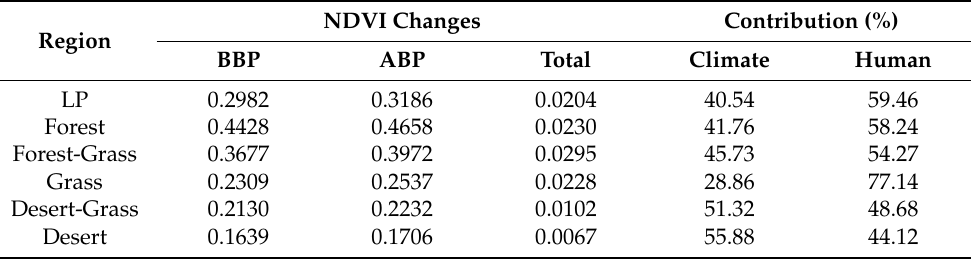
Table 2. The contribution of climate driving forces and human activities for vegetation variations. NDVI Region